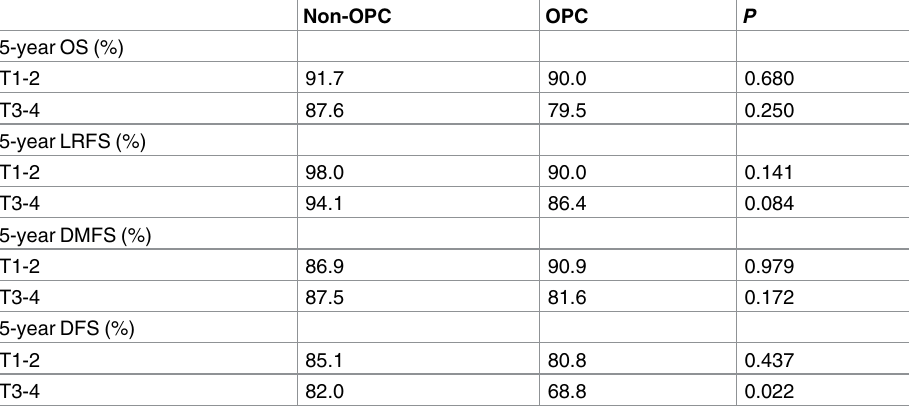
Table 4. Subgroup survival analysis in T1-2 and T3-4 patients.